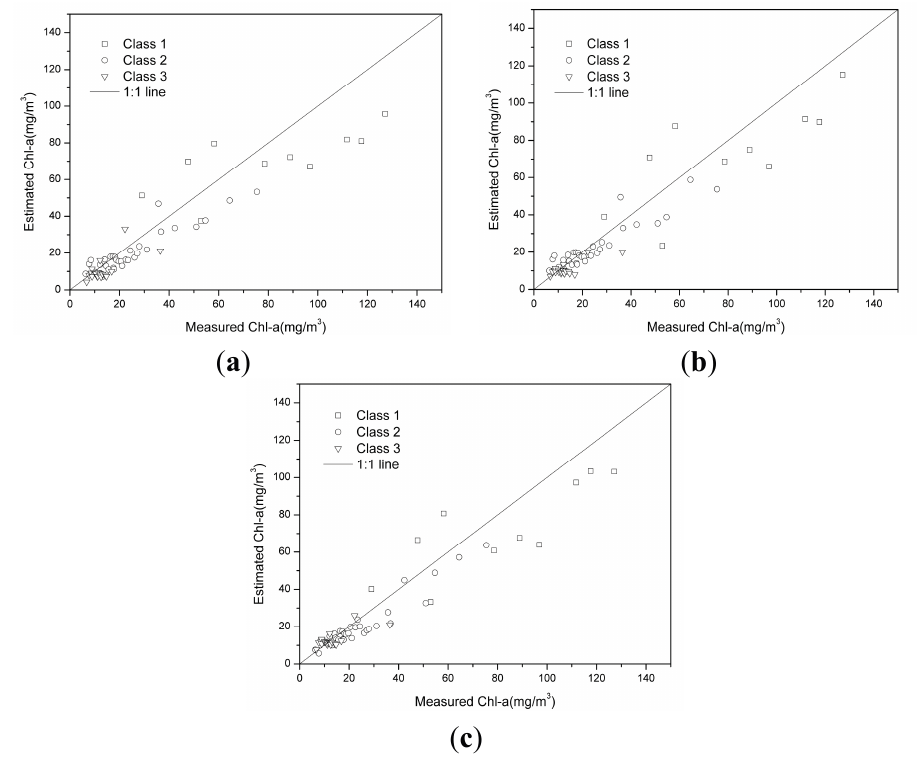
Figure 5. Scatter plot of the measured and estimated values of Chl-a: ( a ) non-classification algorithm; ( b ) hard-classification algorithm; and ( c ) NMI weighted